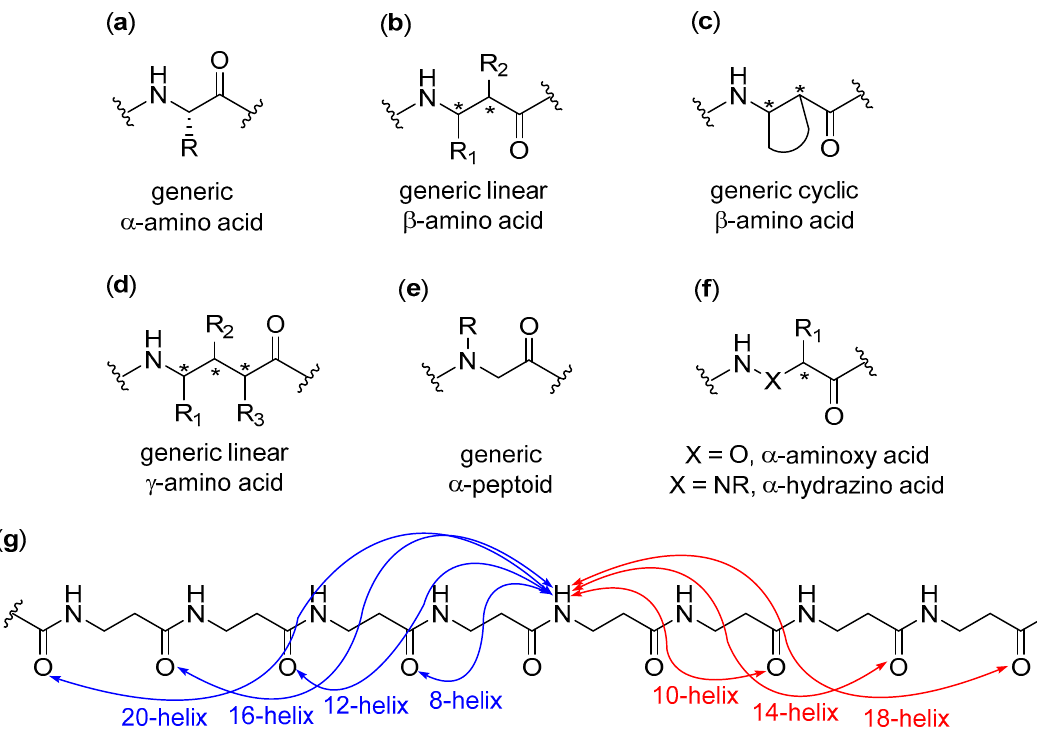
Figure 1. Generic structures of ( a ) proteinogenic α -amino acids, ( b ) linear β -amino acids, ( c ) cyclic β -amino acids, ( d ) linear γ -amino acids, ( e ) α -peptoids, and ( f ) α -aminoxy and α -hydrazino acids; ( g ) The Gellman’s helices nomenclature, reported for a generic β -peptide, in which the numerical indices refer to the number of atoms included in the indicated hydrogen bonded pseudocycles. This nomenclature is also used for higher peptidic homologues. The nomenclature for β -sheets is the same used for α -peptides and it is not reported here (for reviews dealing with the secondary structures of these foldamers, see Refs. [1–9]).